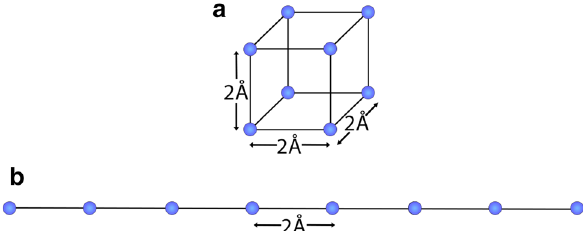
Figure 4. The shape of a molecule affects its polarizability. For example, we find that a cube of 8 carbon atoms 3 separated by 2 Å has an average polarizability of 12Å ( a ) and a line of the same 8 atoms separated by 2 Å has an 3 average polarizability of 20Å ( b